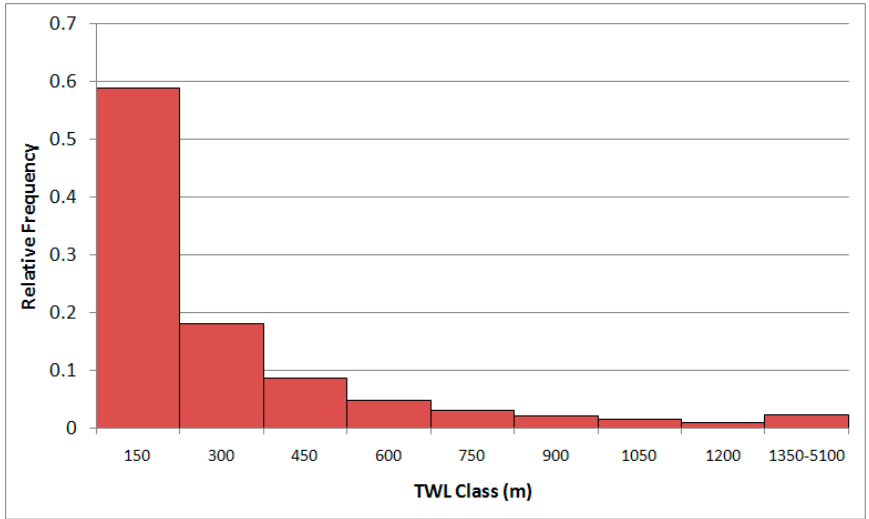
Figure 8. Relative frequency histogram of TWL components, or lengths of a combination of horizontal and vertical 30-m wide transects through forested portions of an NLCD image from the PG study area.